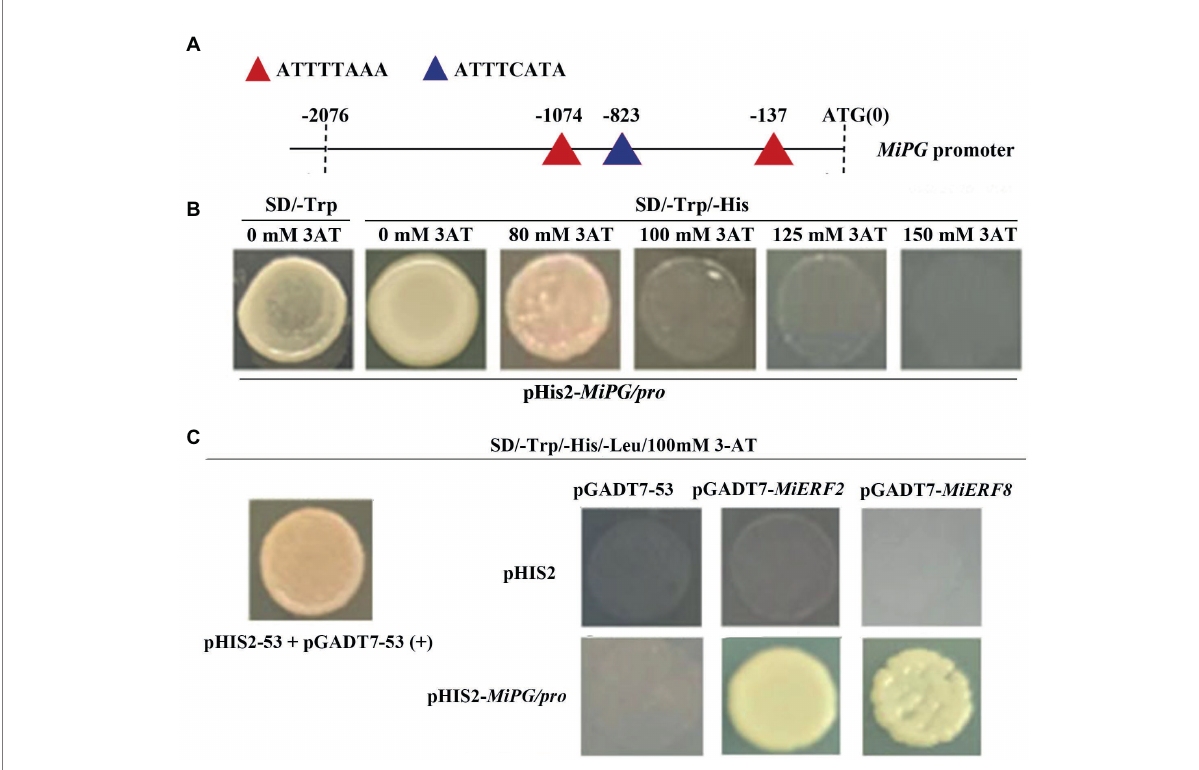
FIGURE 6 Analysis of the interaction between MiERF2 (or MiERF8) and MiPG promoter. (A) Cis -acting element analysis of MiPG promoter. (B) Screening of 3AT concentrations that prevent the auto-activation of MiPG promoter. (C) The interaction between MiERF2 (or MiERF8) and MiPG promoter via yeast